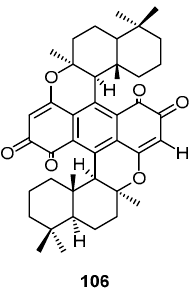
Figure 24. Chemical structure of dipuupehedione ( 106 ).